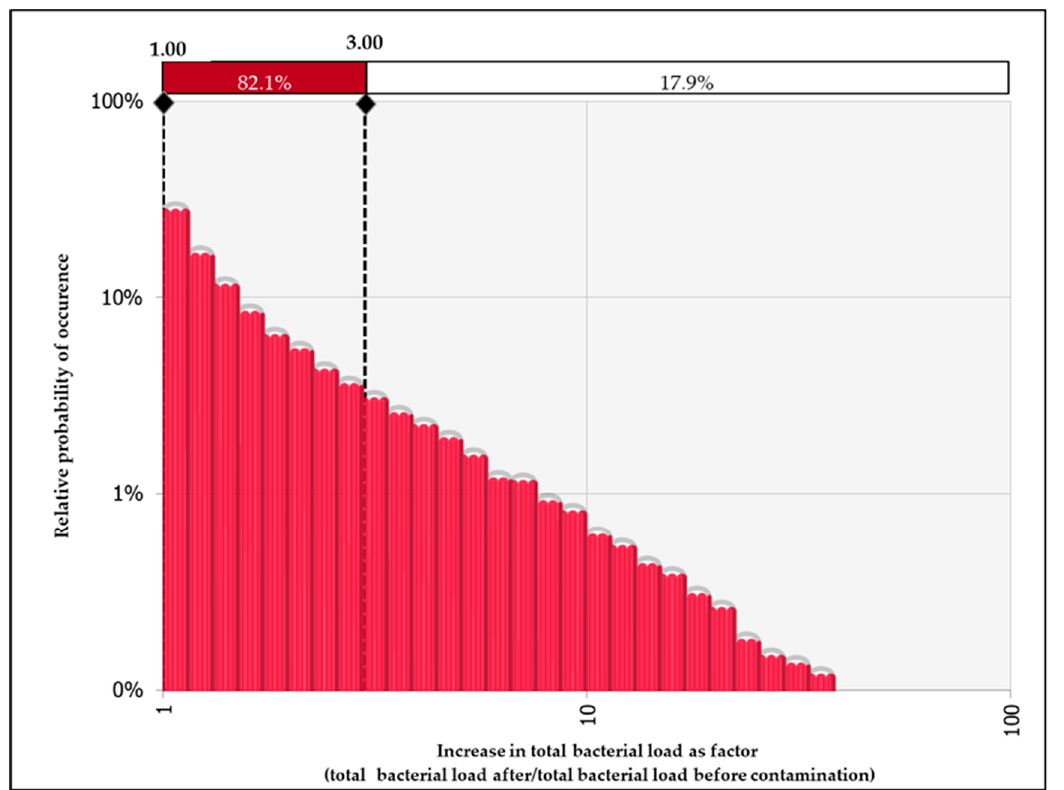
Figure 3. Relative probability of occurrence of different increases in total bacterial load expressed as a factor in the case of E. coli counts and contamination with feces. The red horizontal bar indicates the probability of increase less than three-fold (1.00–3.00), while the white horizontal bar indicates an increase more than three-fold.